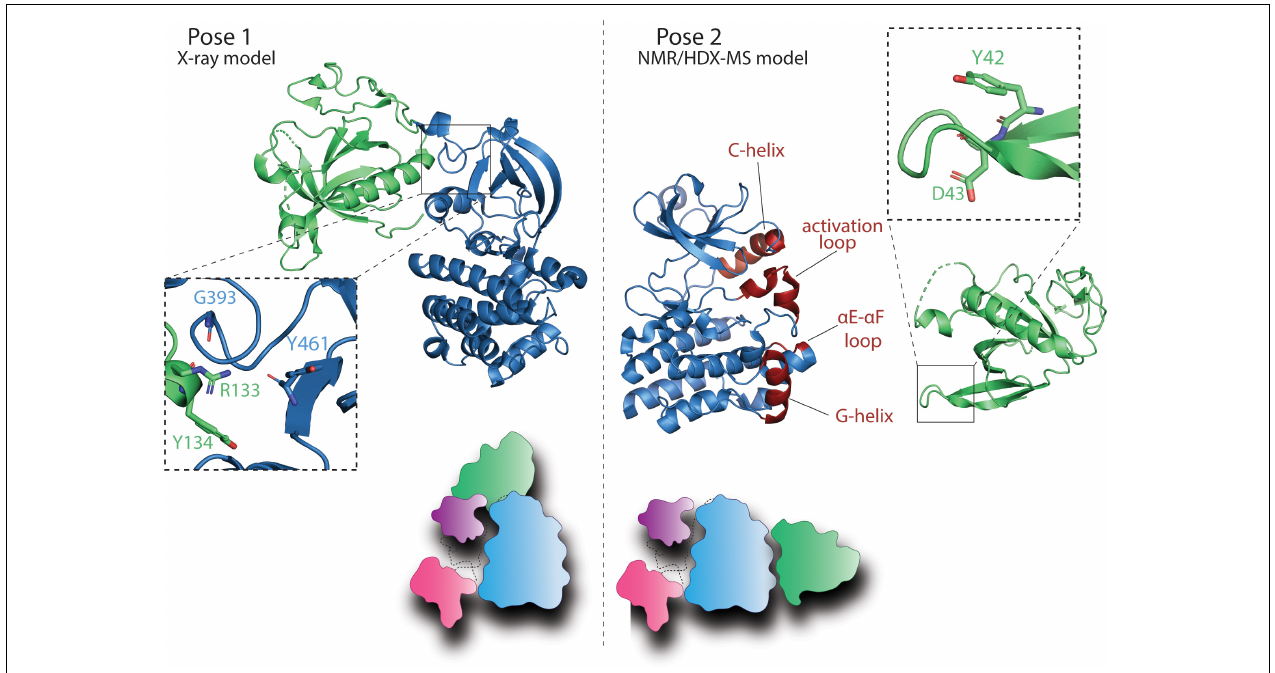
FIGURE 4 | BTK PHTH autoinhibitory interactions. Pose 1: Model derived from the crystal structure of a tethered BTK PHTH-kinase construct (PDB: 4Y93) reveals contacts between the PHTH domain and the kinase domain N-lobe [partially overlapping with the autoinhibitory site of the SH3 domain (Wang et al., 2015)]. Domain colors are as in Figure 3A . The expanded region (dashed box) shows the interaction between R133 and Y134 in the PHTH domain and G393 and Y461 in the kinase domain. The cartoon depiction shows the PHTH/kinase interaction in the context of the autoinhibited SH3–SH2-kinase structure described in Figure 3 . Pose 2: Solution NMR, HDX-MS, and biochemical data reveal another autoinhibitory interaction between the PHTH and the activation loop face of the kinase domain (Devkota et al., 2017; Joseph et al., 2017; Amatya et al., 2019). The PHTH domain residues involved in this autoinhibitory pose are Y42 and D43 (dashed box) while the structural elements in the kinase domain reported to mediate this interaction include the α C-helix, the activation loop (A-loop), the α E– α F loop, and the α G-helix (colored in red). The cartoon depiction shows this PHTH/kinase interaction in the context of the autoinhibitory SH3–SH2-kinase structure described in Figure 3